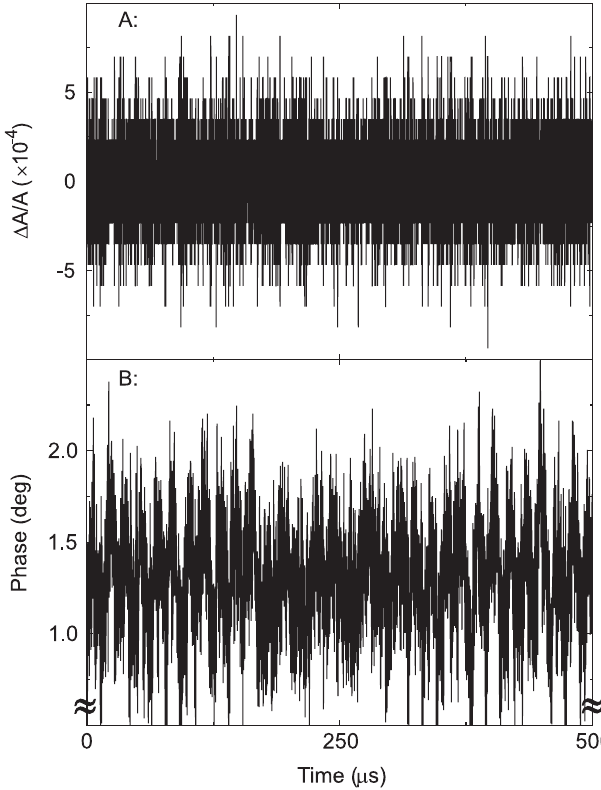
FIG. 8. Amplitude ( A ) and phase ( B ) error of the digital control system without an integral controller in the phase loop.